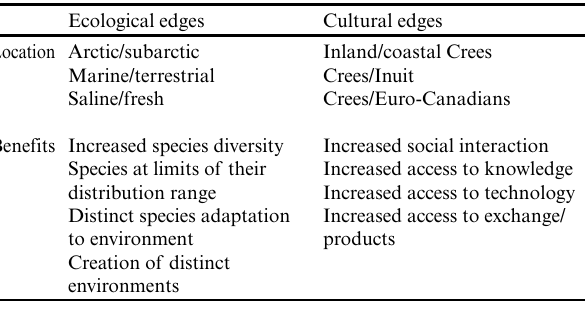
Table 1 . Ecological and cultural edges of the Wemindji